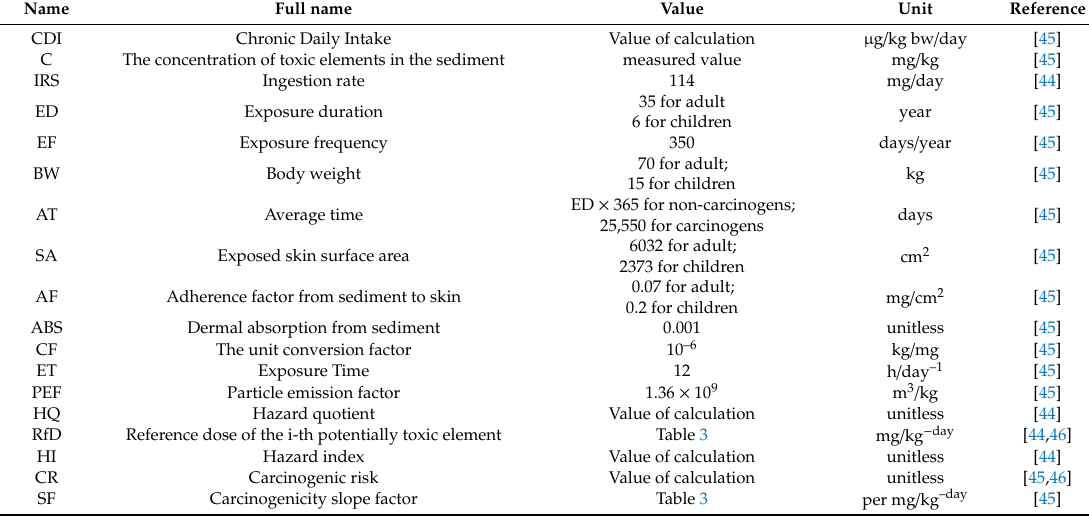
Table 2. The formula explanations and value sources of human health risk